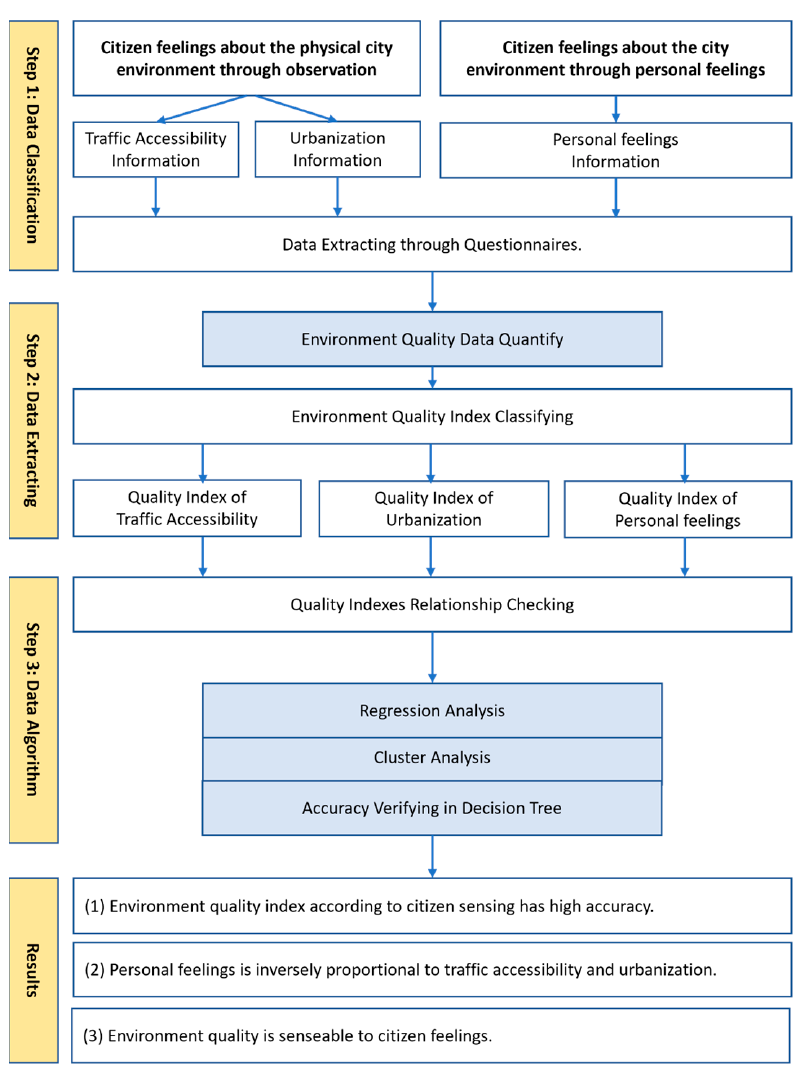
Figure 3. System flowchart of experiment. The data are extracted according to the information sources separately and are quantified into numbers for classifying and analyzing, to obtain the indexes of environment quality. The indexes are used for measuring environment quality.